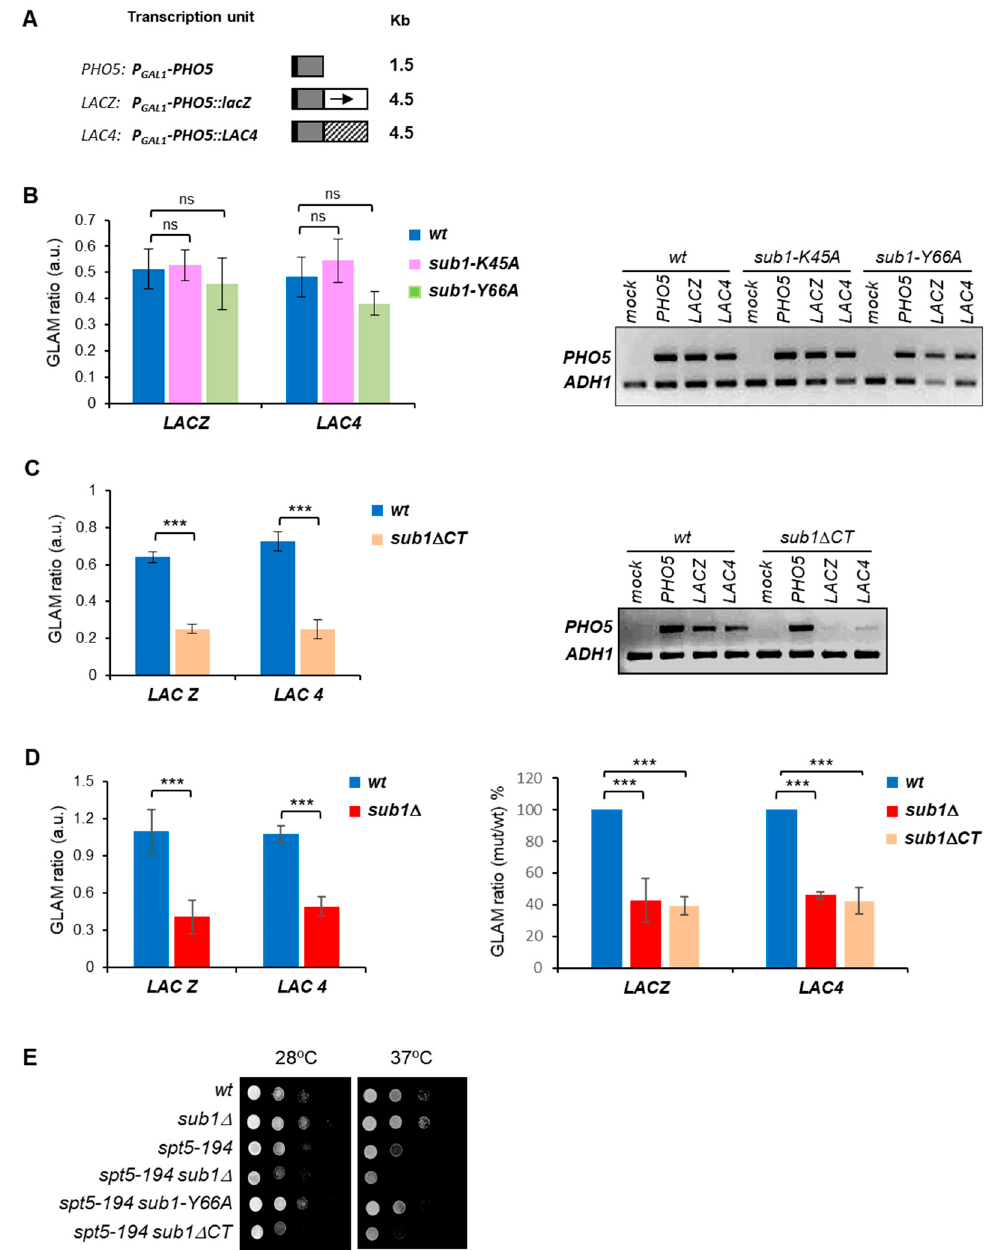
Figure 3. The deletion of the CT region of SUB1 causes reduced transcription elongation efficiency of long transcripts. ( A ) A schematic representation of the three transcription units used in the GLAM assays. ( B ) The graph on the left shows the GLAM ratios, and the right panel shows PHO5 expression from the short and long transcription units. As mock, a strain containing an empty plasmid was used. ADH1 expression was used as a loading control. ( C ) GLAM ratios (left) and RT-PCR results (right) for the wt and sub1 ∆ CT strains. Statistically significant levels are shown where ns = non-significant, ***= p < 0.001. ( D ) Left, GLAM ratios for wt and sub1 Δ . Right, comparison of transcription elongation defects between sub1 Δ and sub1 Δ CT relative to wt , set as 100%. ( E ) Allele-specific interaction between SUB1 Δ CT and SPT5 ; the indicated yeast strains were spotted onto SC media plates and incubated at 28 °C or 37 °C for 2–3 days.